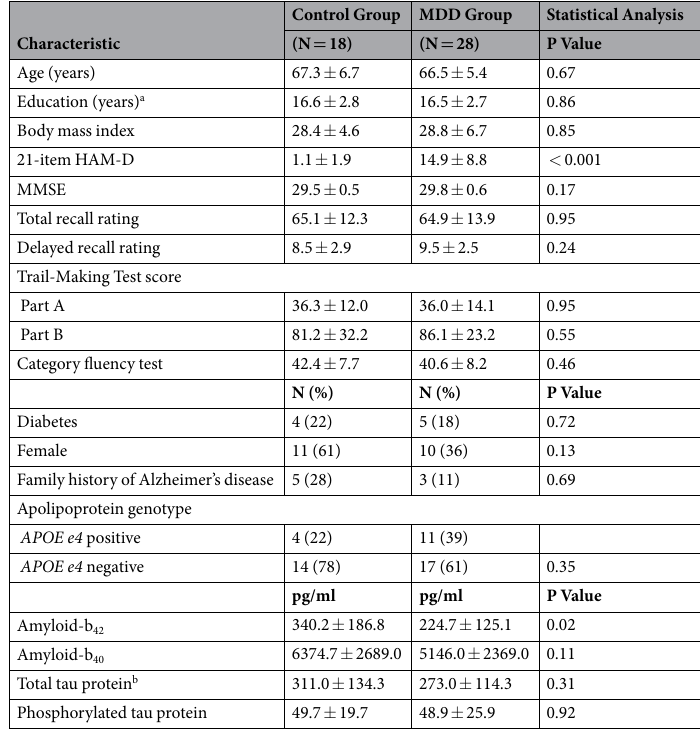
Table 1. Demographic and Clinical Characteristics of Cognitively Intact Individuals with MDD and Age- Matched Control Subjects at Baseline. The data are the mean ± standard deviation (SD). 21-item HAM-D: 21- item Hamilton Depression Rating Scale, MMSE: Mini-Mental State Examination. a Data for one control subject were not available. b Data for one MDD patient were not available. The data at baseline are from Pomara et al . 26